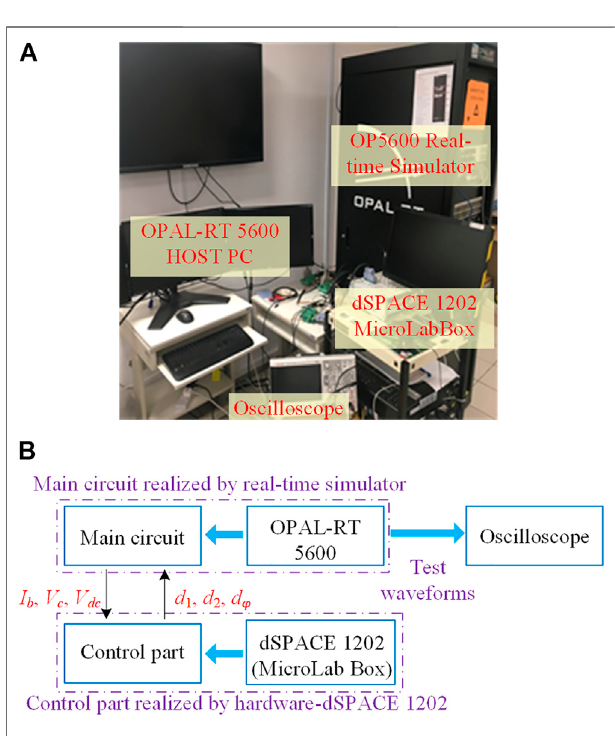
FIGURE 8 | The HIL test system: (A) the picture of the HIL system; (B) the schematic diagram of the HIL